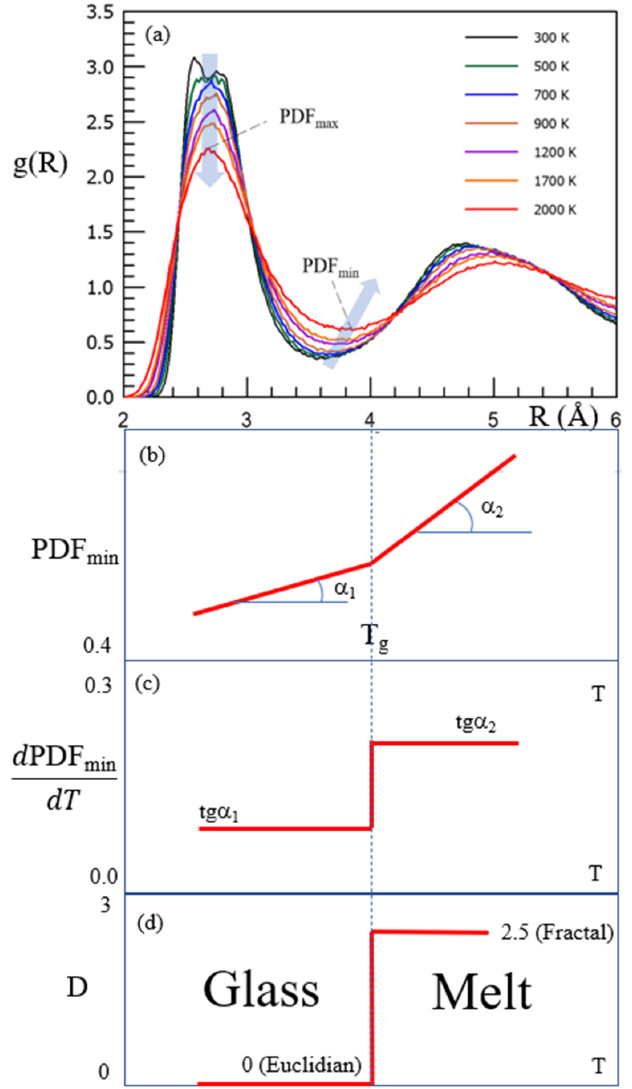
Figure 7. Schematic of the pair-distribution function PDF(R) = g(R) of amorphous Ti 2 Ni ( a ). Re- printed with permission from [25]. Copyright 2020 American Chemical Society. The prominent changes during the glass transition of PDF min ( b , c ) and the Hausdorff-Besicovitch dimension of con- figurons set ( d